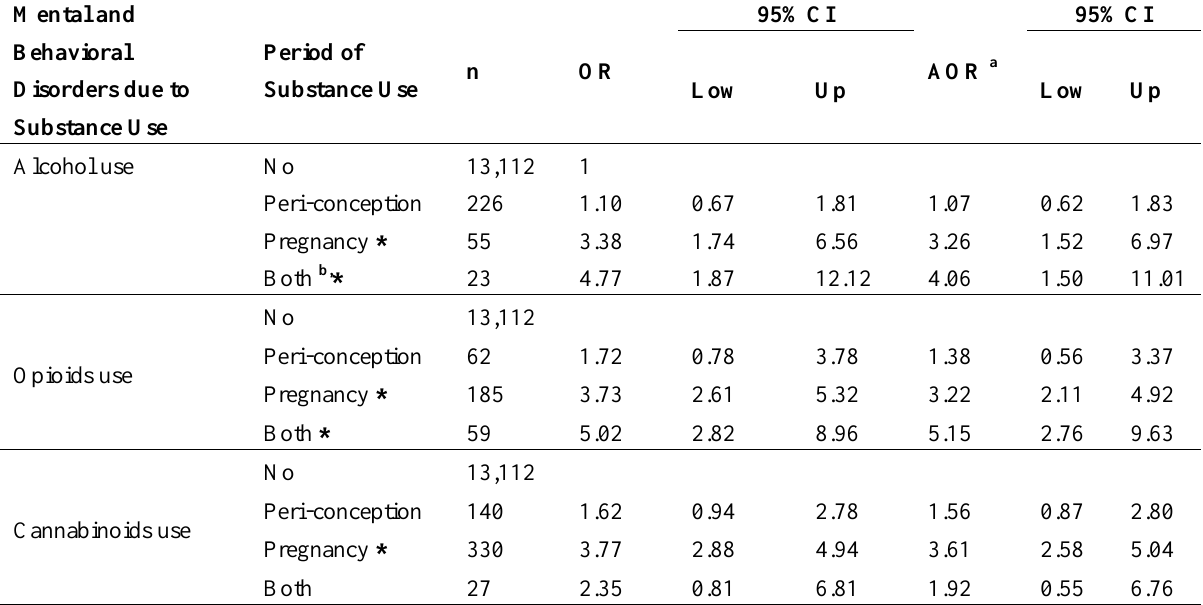
Table 3. Mental and behavioral disorders due to substance use in peri-conception and pregnancy and preterm